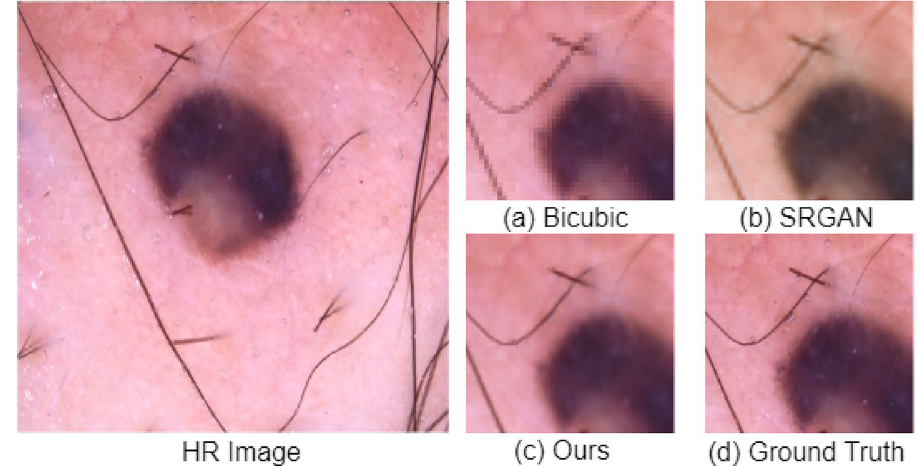
Figure 9. Small region results on image from ISIC skin cancer dataset. The sub-region for ( a ) Bicubic interpolation. ( b ) SRGAN 31 . ( c ) Proposed architecture. ( d ) Ground truth HR image.